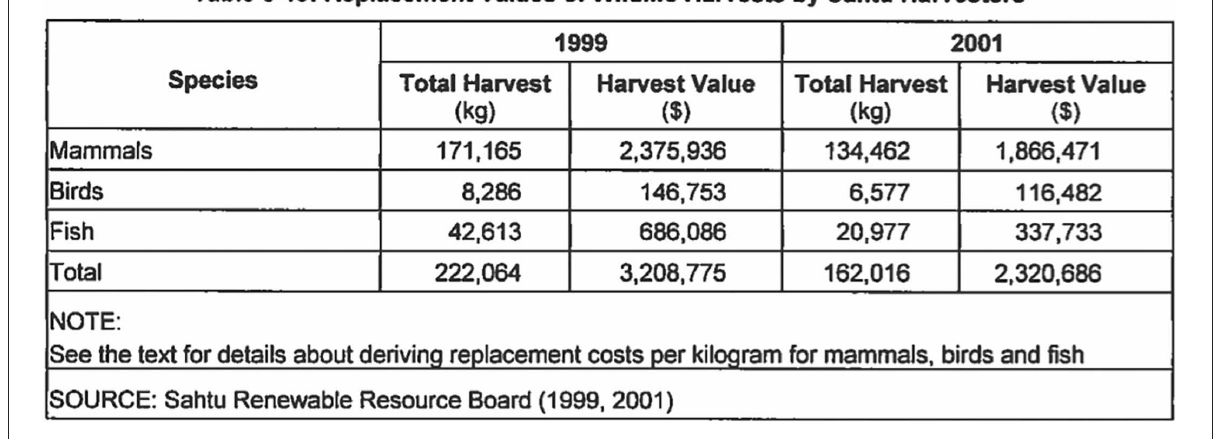
FIGURE1 Table of the calculation of the replacement value of wildlife harvests by Sahtu harvesters included in the Mackenzie Gas Project environmental impact statement, prepared by Imperial Oil (MGP., 2004a, Vol. 4, Section 5: 5–19).